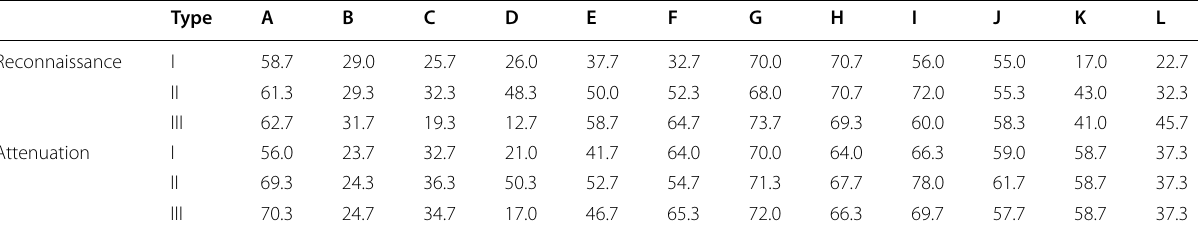
Table 12 Scores of NASA-TLX for each type